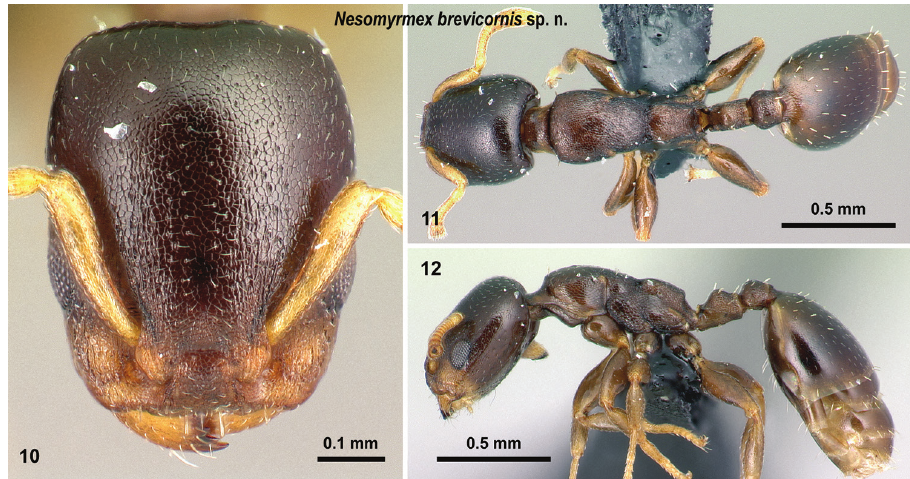
Figures 10–12. Nesomyrmex brevicornis sp. n. holotype worker (CASENT0027494). Head in full-face view ( 10 ), dorsal view of the body ( 11 ), lateral view of the body ( 12